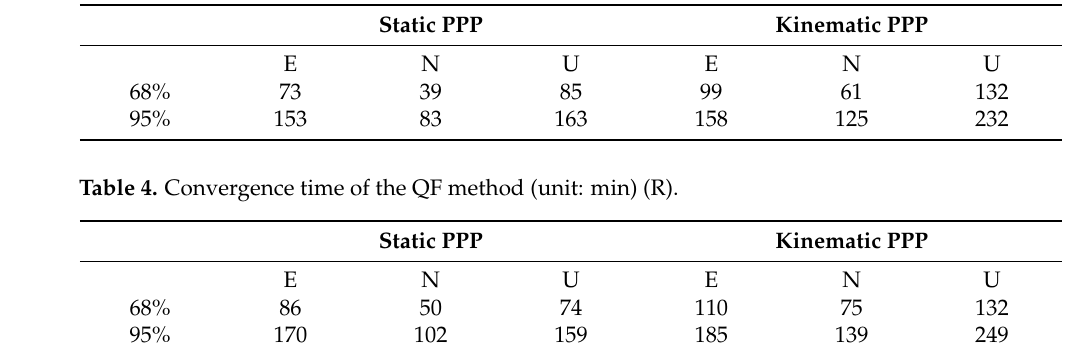
Table 3. Convergence time of the EG method (unit: min) (R).